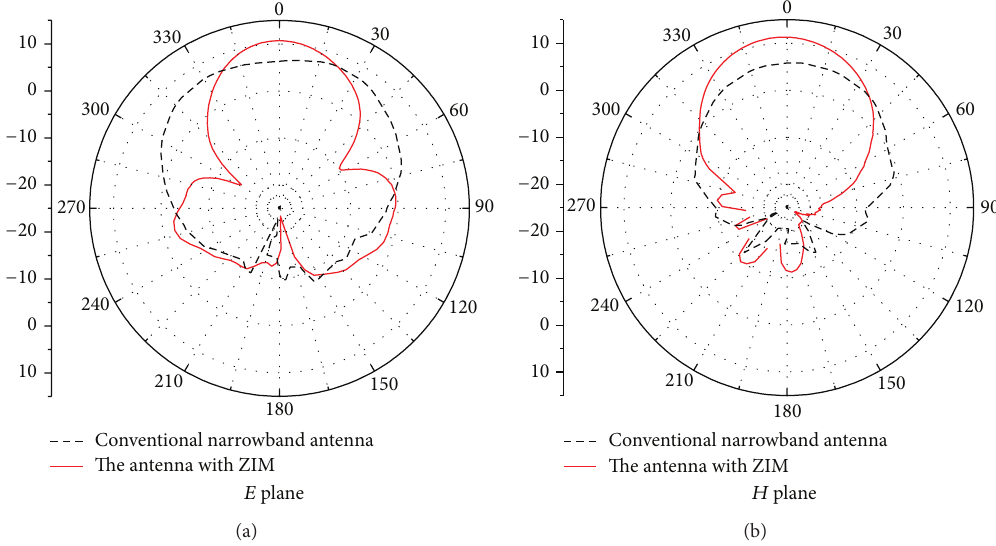
Figure 8: The measured radiation patterns for the conventional narrowband antenna and the antenna with the ZIM cover.